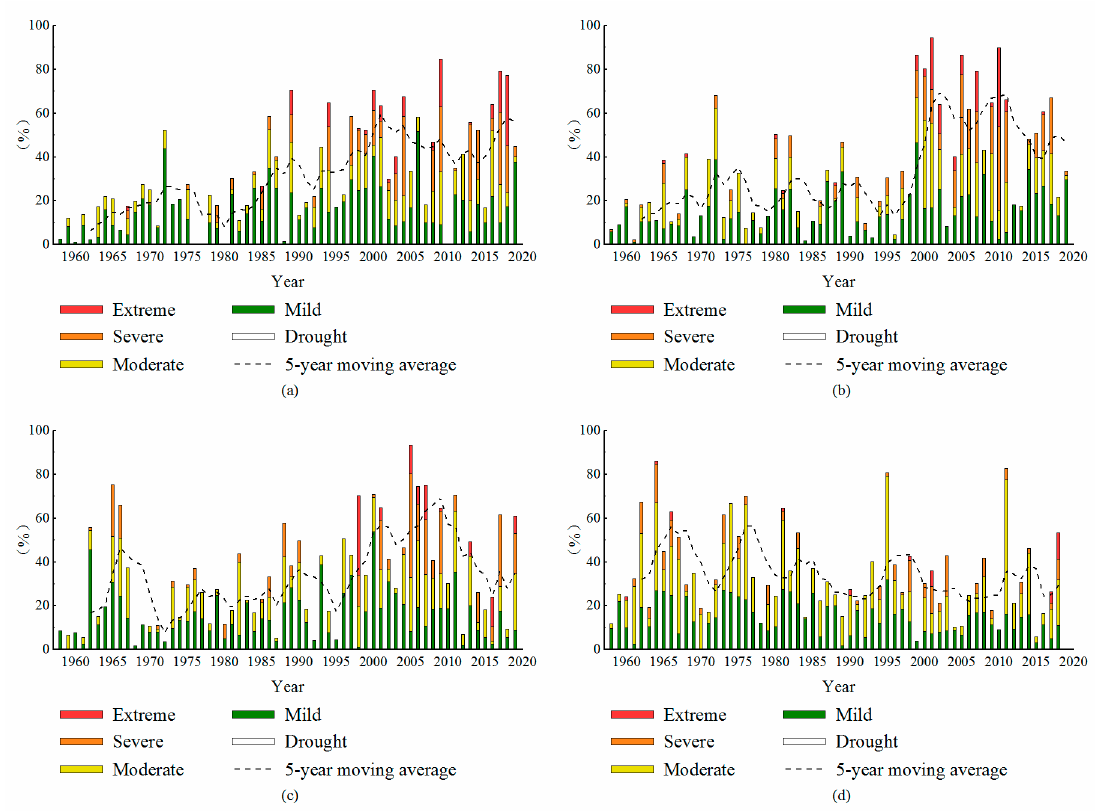
Figure 7. The changes in the proportion of drought area in ( a ) spring, ( b ) summer ( c ) autumn and ( d ) winter, over the years.